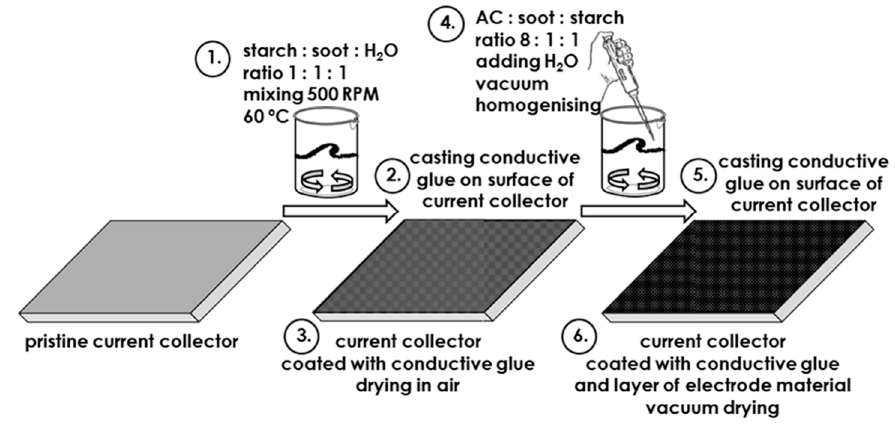
Figure 1. Scheme of the experimental procedure.